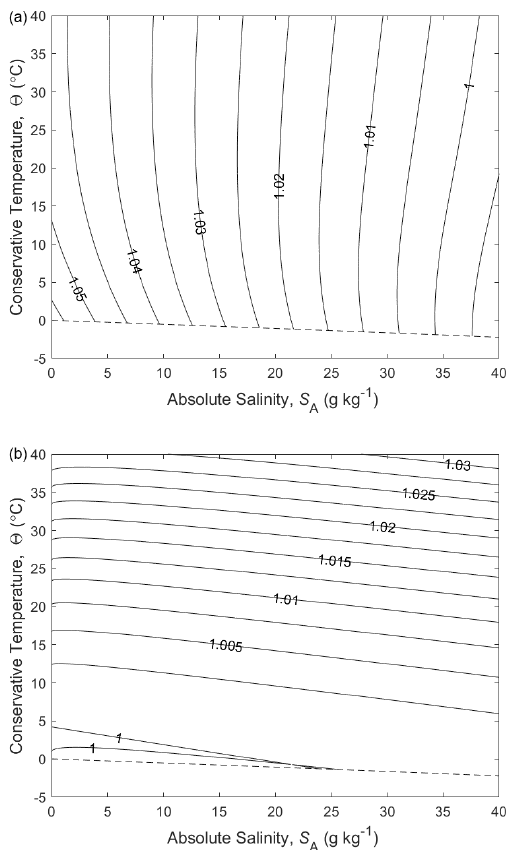
Figure 7. (a) The ratio of the thermal expansion coefficients with respect to Conservative Temperature and potential temperature, ˜ α θ / ˆ α (cid:50) = ˜ (cid:50) θ . (b) The ratio of the saline contraction coefficients at constant potential temperature to that at constant Conservative / ˆ θ (cid:50) , at p = Temperature, ˜ β θ / ˆ β (cid:50) = 1 + ( ˆ α (cid:50) / ˆ β (cid:50) ) ˆ θ S A